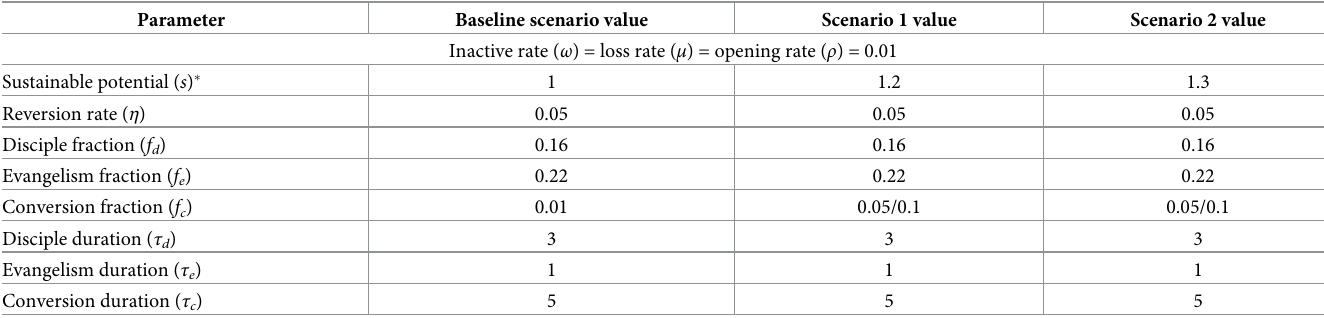
Table 1. Parameters and values of model.